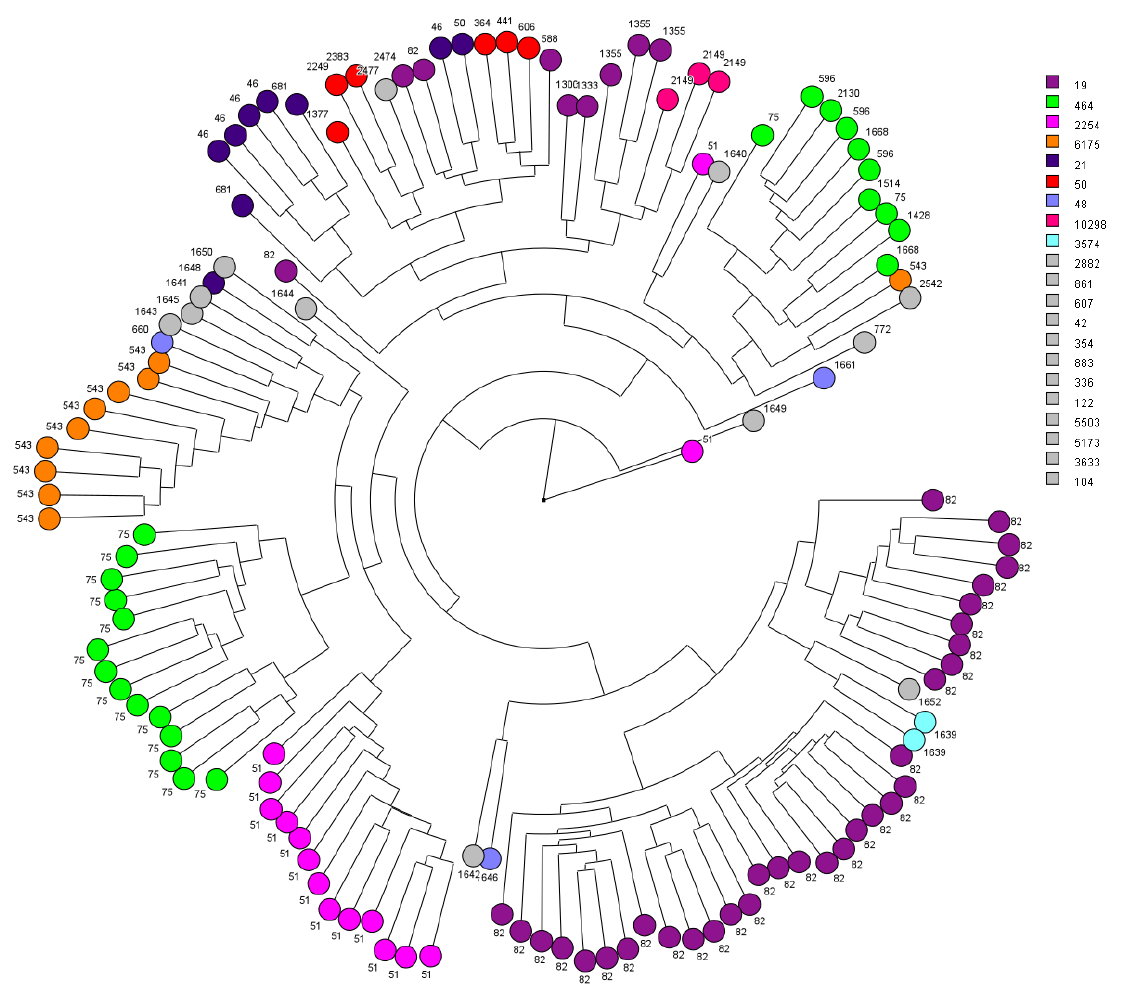
Figure 1. Circular top-score UPGMA dendrogram (ranked Pearson correlation coefficient) based on MSPs grouped by their sequence type (ST) profiles using logarithmic scaling. The whole spectra have been used to compute the figure ( n = 91 peaks). Colours represents specific ST and outside numbers are CT profiles. Gray colour represents groups with one representant per